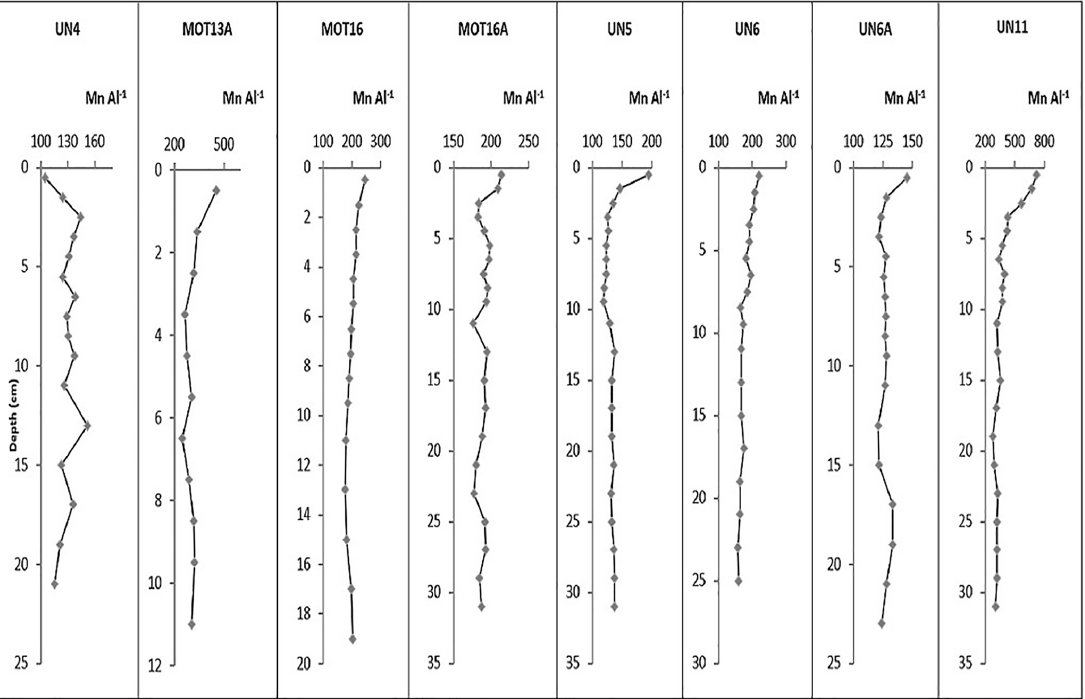
Figure A9. Vertical distributions of Mn Al − 1 × ( 10 4 ) in sediment cores. The ratios in the coarse cores MOT13A, MOT16 and UN4 are calculated at the fine-sediment fraction ( < 63µm).